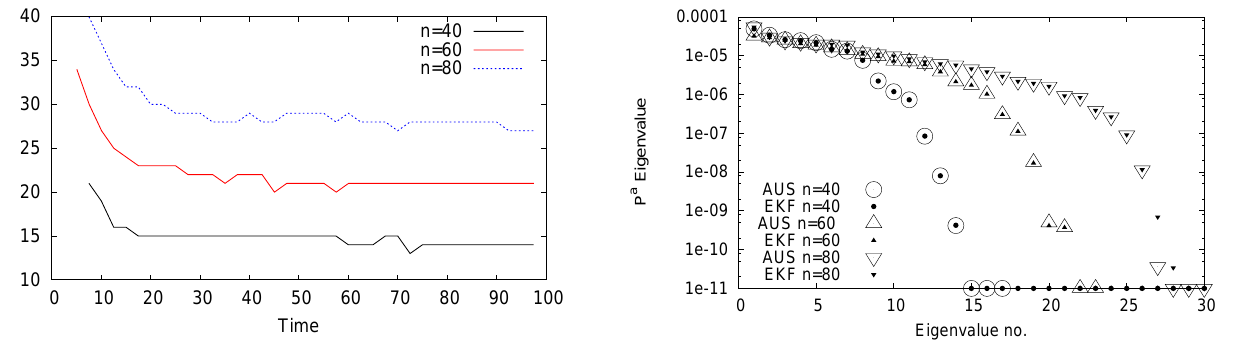
Fig. 3. Eigenvalues of the analysis error covariance matrix at final time of assimilation with: EKF (full) and EKF-AUS (empty) for systems with n = 40 , 60 , 80. σ 0 = 0 .